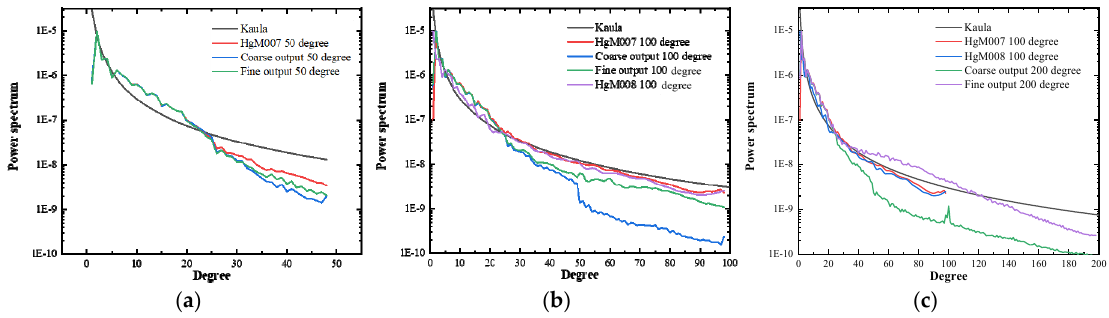
Figure 10. Power spectrum curves of gravity data. ( a ) 50 degree; ( b ) 100 degree (×2); ( c ) 200 degree (×4).